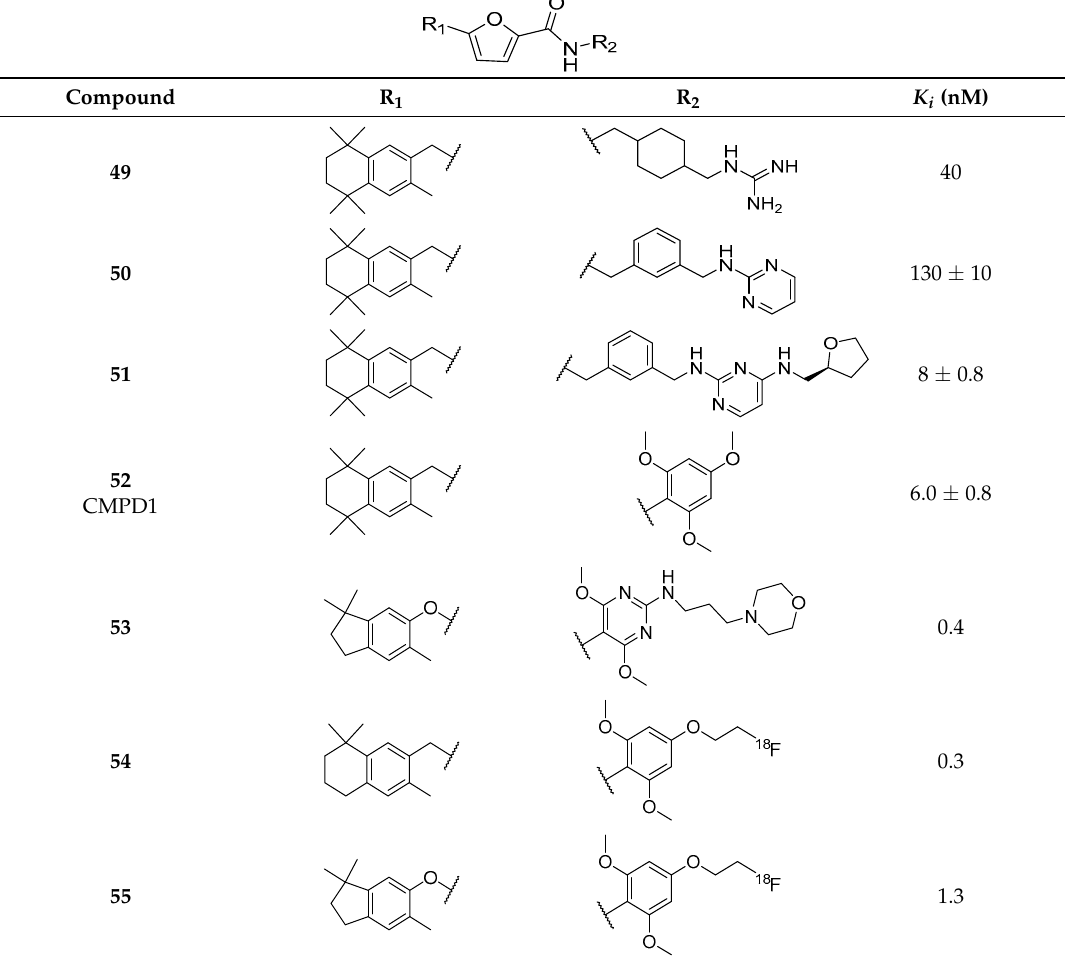
Table 9. Furamide derivatives and their binding affinity at human GnRH-R.